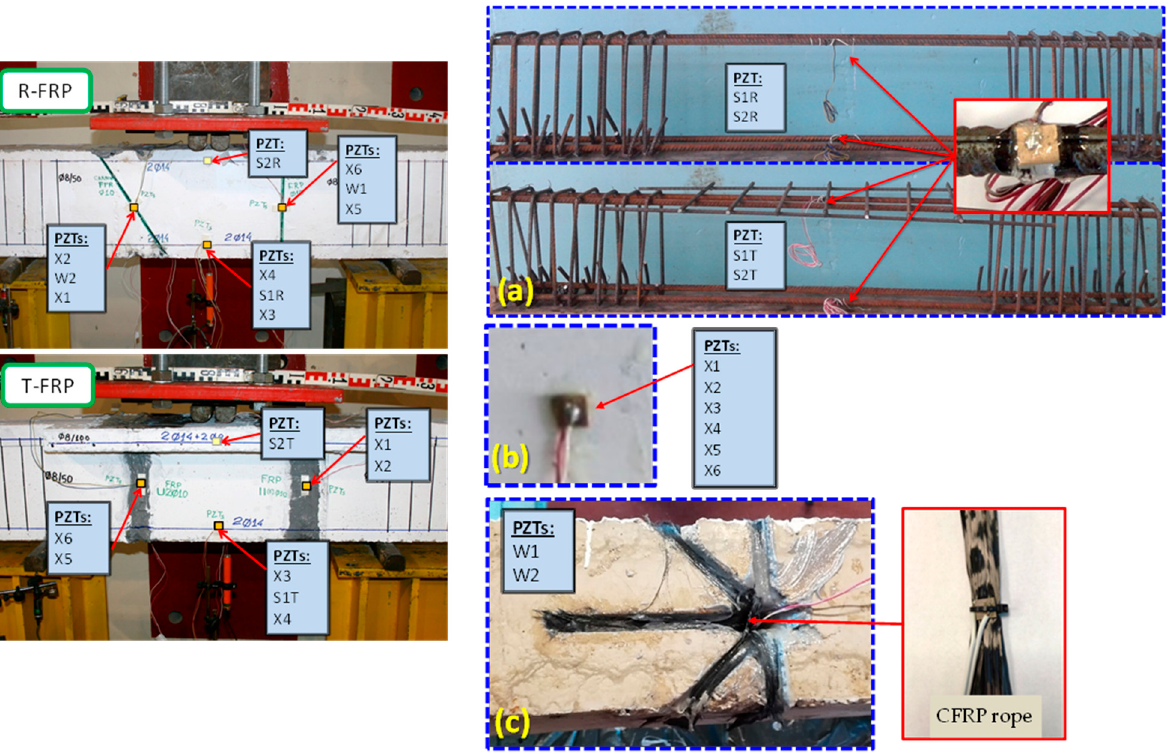
Figure 5. Installation of PZTs transducers: ( a ) epoxy-bonded PZTs on the reinforcing steel bars, ( b ) externally epoxy-bonded PZTs mounted to the concrete surface, and ( c ) embedded PZTs transducers on C-FRP ropes.